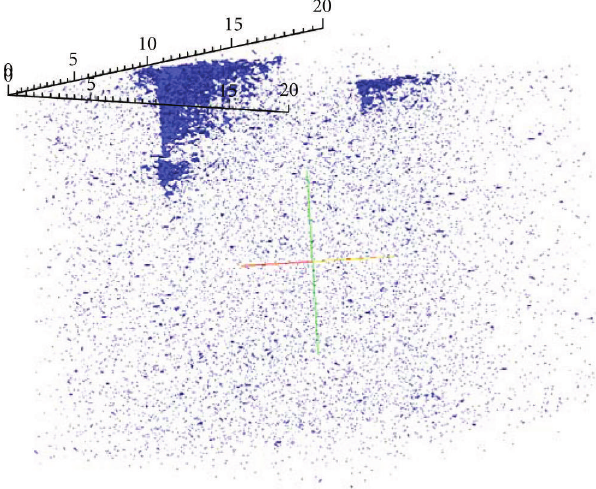
Figure 7: Calibration plot for boron in doped silicon wafers showing a linear fit to the measured points (three standards and one blank), and 95% confidence limits. An oxygen partial pressure of 6.0 × 10 − 5 mbar was used to enhance the signal; the primary beam was 30keV, > 14.7nA with a scan area of 10 by 10 µ m (the current cannot be measured above 14.7 nA). The limit of detection under these conditions for this material was 5.5